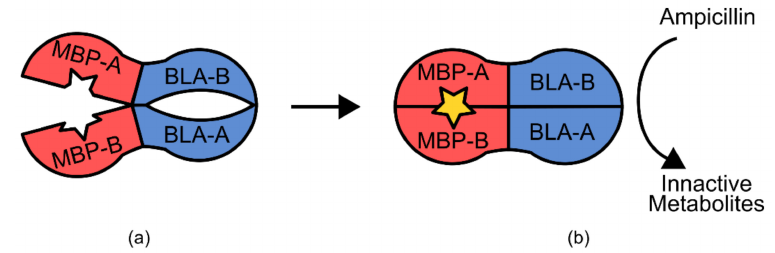
Figure 12. Maltose Biosensor. This biosensor is one fusion protein comprised of a maltose-binding peptide (MBP) and a β -lactamase enzyme (BLA), each of which has been split into two portions (A and B): ( a ) In the absence of maltose, the MBP-A and MBP-B domains exist in an open hinge conformation, disrupting the structure of the fused BLA-A and BLA-B domains. ( b ) Upon binding of maltose (star) to the MBP-A and MBP-B domains, this hinge closes, bringing the BLA-A and BLA-B domains back into the correct position. This reconstitutes the enzymatic activity of the BLA protein, allowing cells expressing this biosensor to grow in the presence of β -lactam antibiotics as a signal